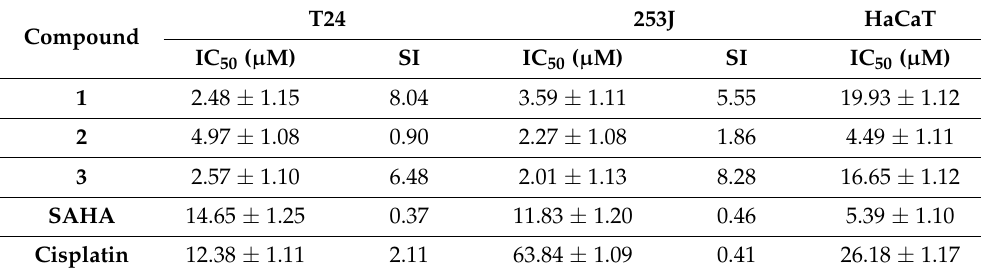
Table 1. Antiproliferative activity in T24 and 253J cancer cells along with selectivity index and the antiproliferative activity in the non-cancer cell line HaCaT.